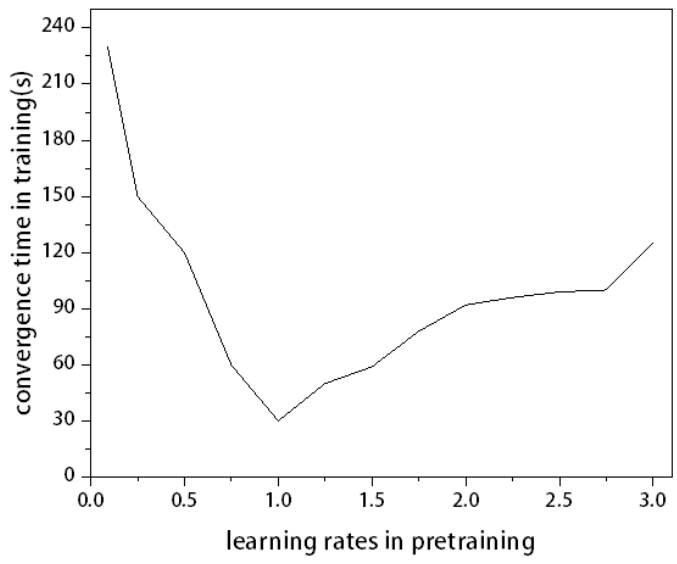
Figure 5. Convergence time in training with different learning rates in pretraining.